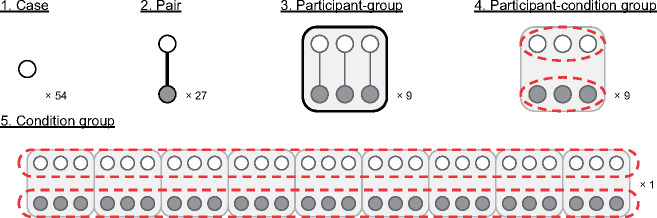
Illustration of blinding information at each step of classification.